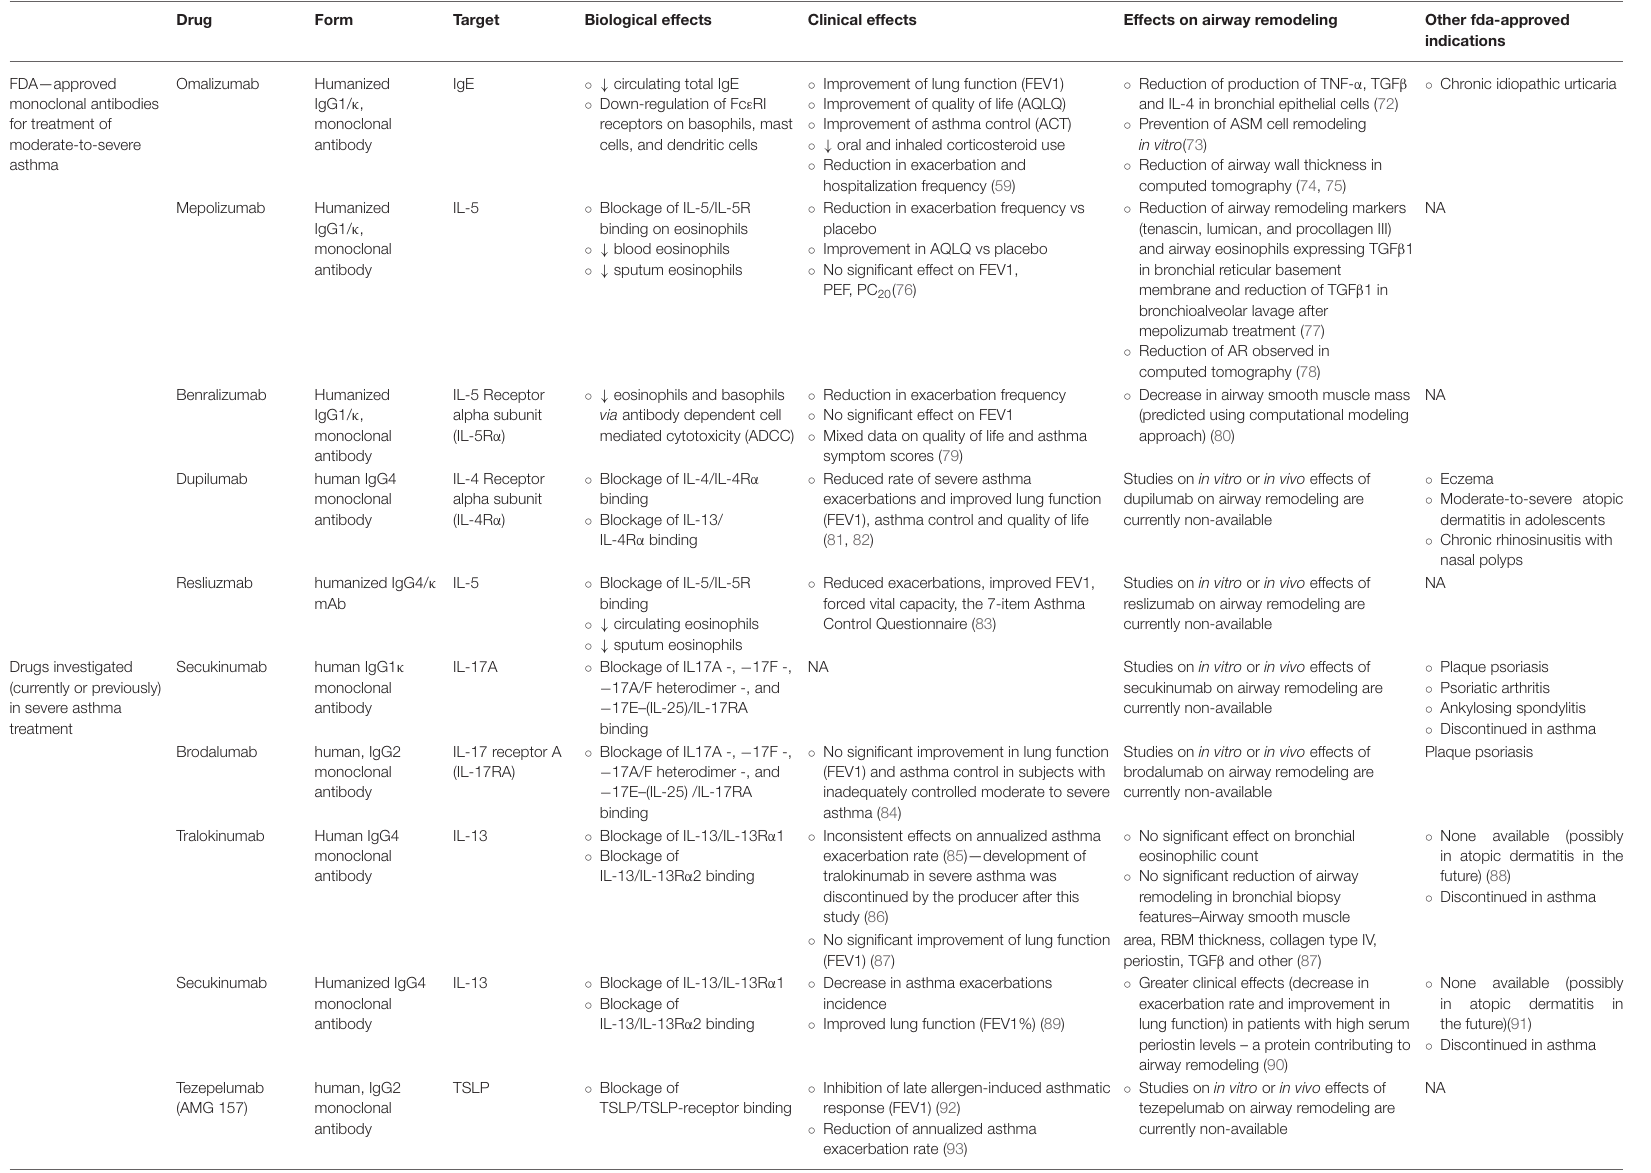
The table includes approved and emerging therapies with published human data. NA, none